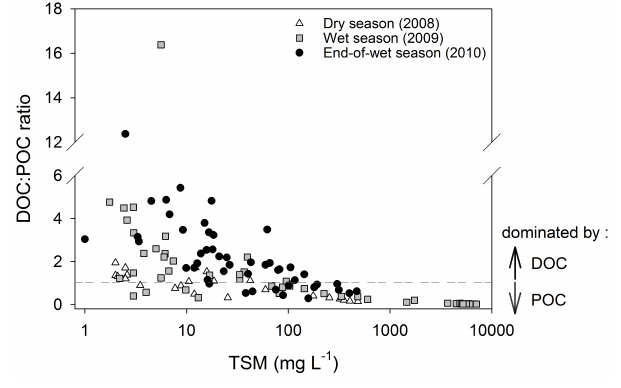
Fig. 7. Relation between DOC:POC ratio vs. TSM along Tana River Basin, (B) %OC vs. δ 13 C OC for tributaries upstream of Masinga reservoir. Horizontal line in panel (A) indicates a DOC:POC ratio of 1.